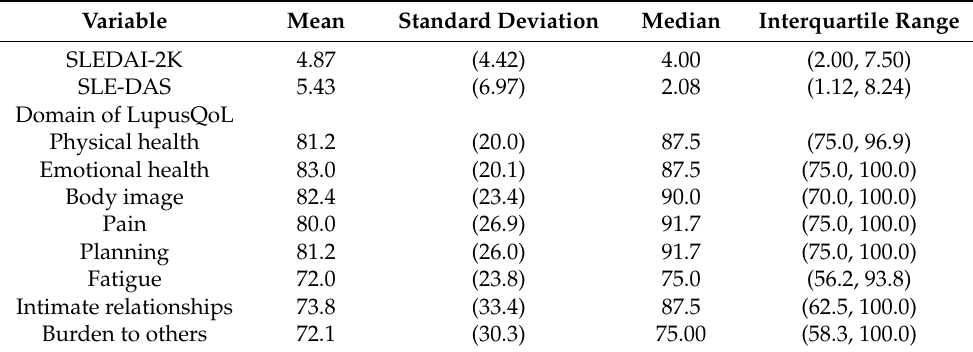
Table 2. Systemic Lupus Erythematosus Disease Activity Score (SLE-DAS), Systemic Lupus Ery- thematosus Disease Activity Index 2000 (SLEDAI-2K), and Lupus Quality of Life (LupusQoL) of patients with systemic lupus erythematosus ( N =